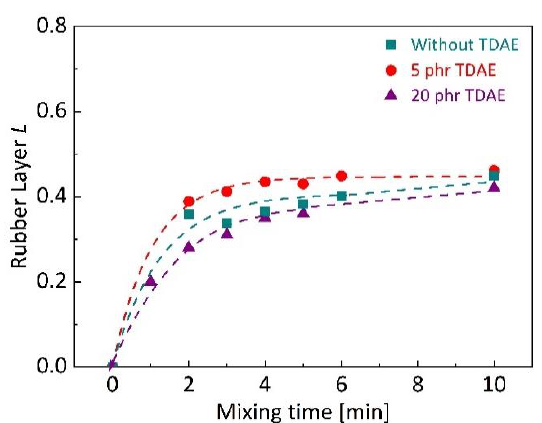
Figure 4. Dependence of rubber layer L development during mixing on TDAE content in silica-filled SBR/BR binary blends.